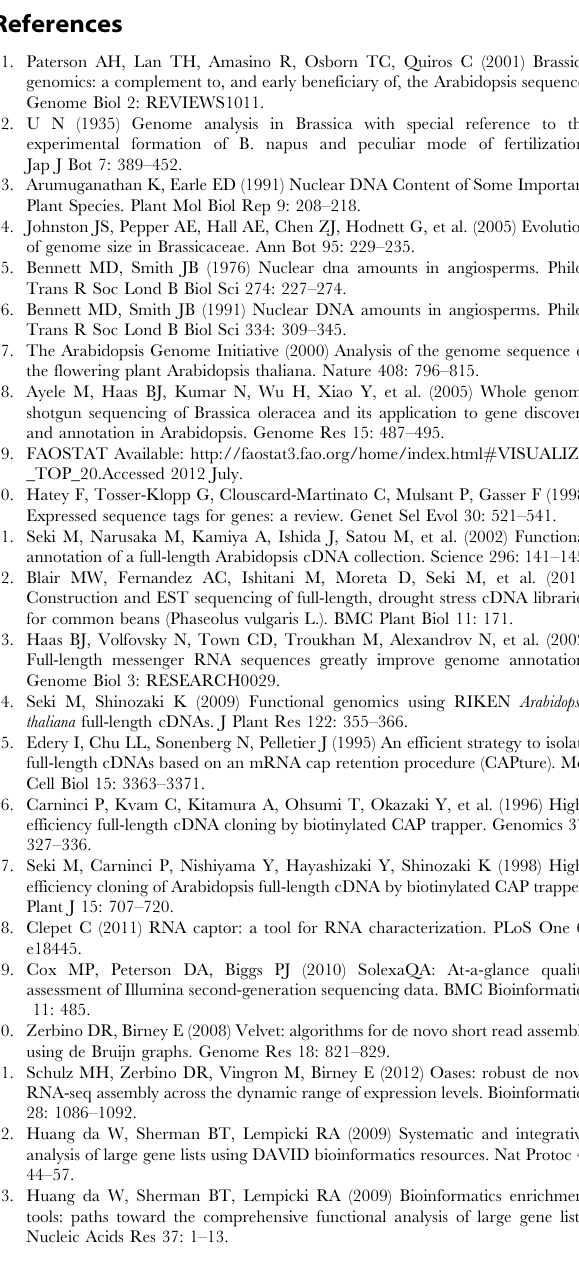
Figure S1 Summary of Cabbage transcriptome assembly. Table S1 Annotation of Cabbage transcriptome assembly. Table S2 GO terms of Cabbage transcriptome assembly. Table S3 KEGG annotation of Cabbage transcriptome assem- bly. Table S4 List of SNPs between two cabbage cultivars.